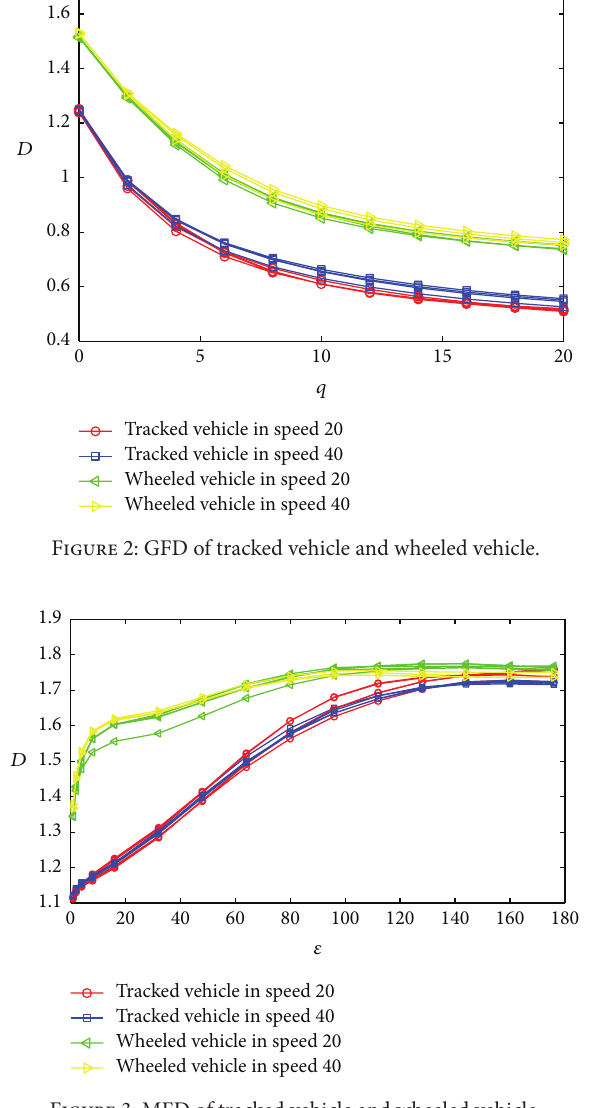
Figure 3: MFD of tracked vehicle and wheeled